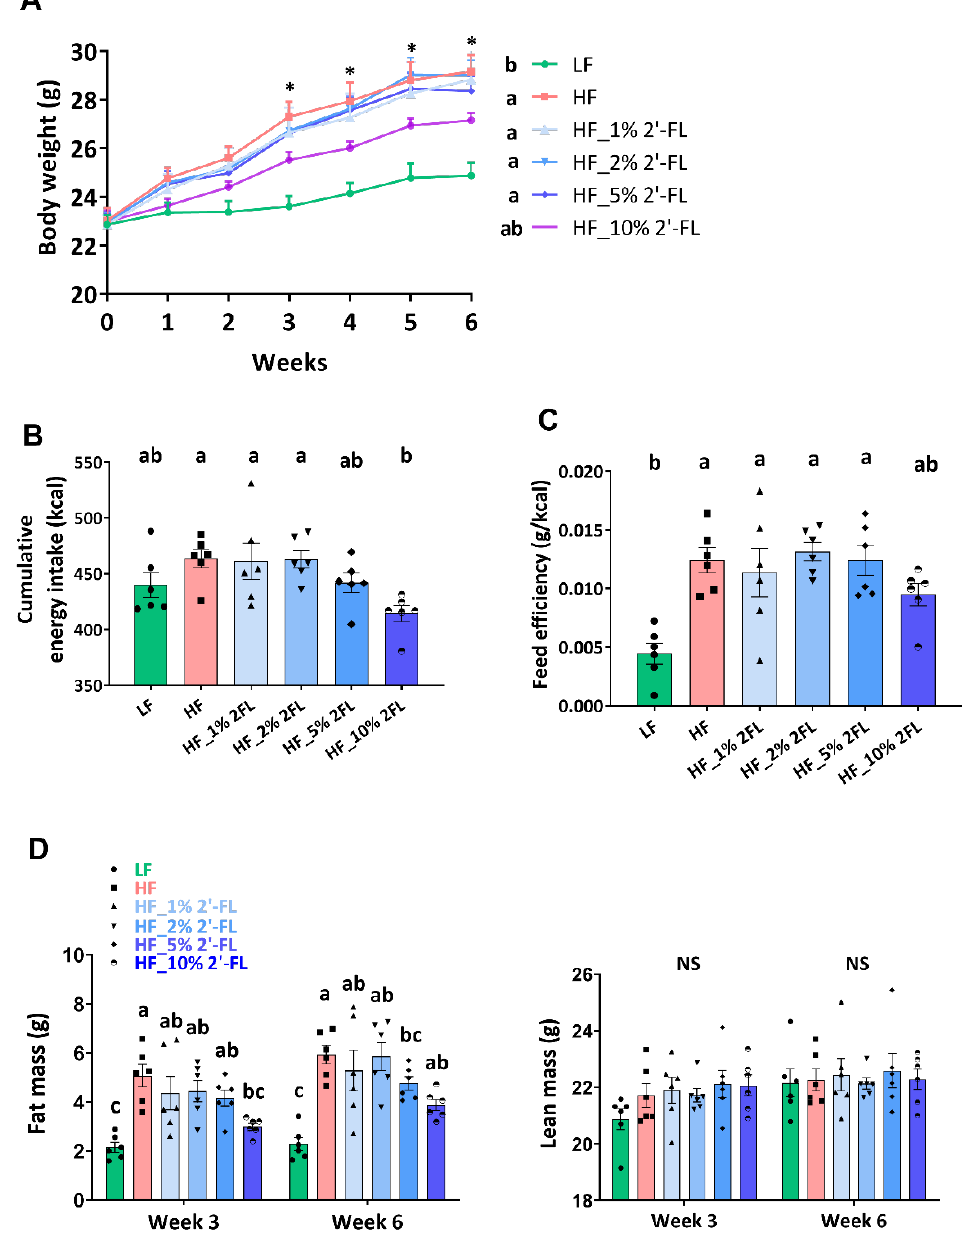
Figure 1. Effect of 2 ′ -FL supplementation on hyperphagic phenotypes. Body weight ( A ), cumulative energy intake (for 5 weeks; B ), feed efficiency (weight gain (g)/energy intake (kcal) for 5 weeks; C ), and body composition ( D ) in mice fed an LF, HF, or HF_2 ′ -FL (1, 2, 5 or 10%) diet for six weeks. Two-factor repeated-measures ANOVA was used to analyze body weight and body composition. One-factor ANOVA was performed to analyze data from energy intake and food efficiency. Differences between groups were analyzed by using Tukey’s post hoc tests. Values are means ± SEMs, n = 6/group. Histogram with different letters (a or b) denotes mean values that are statistically different at P < 0.05; for all variables with the same letter, the difference between the means is not statistically significant and if two variables have different letters, they are significantly different. NS, not significant. * denote significant differences among groups at P < 0.05. ANOVA, analysis of variance; HF, high fat; HF_x% 2 ′ -FL, HF with x% 2 ′ -FL ( w / v ) in drinking water; LF, low fat; 2 ′ -FL, 2-fucosyllactose.